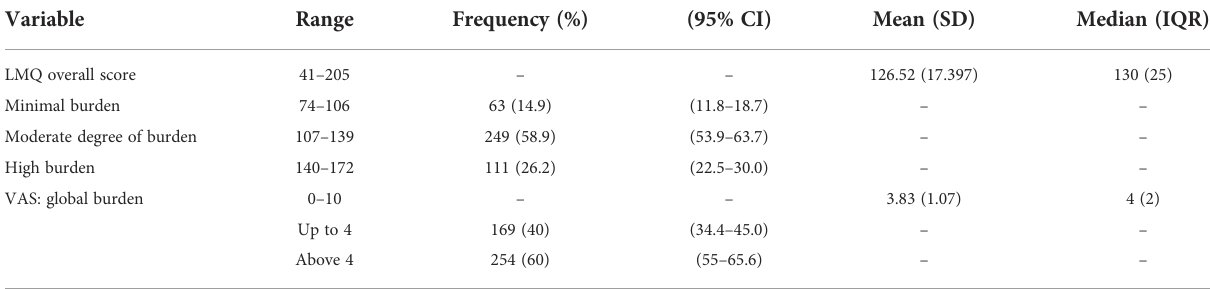
TABLE 3 Descriptive summary of perceived medication-related burden by LMQ-3 and VAS score in DM patients attending at Felege Hiwot Comprehensive Specialized Hospital.